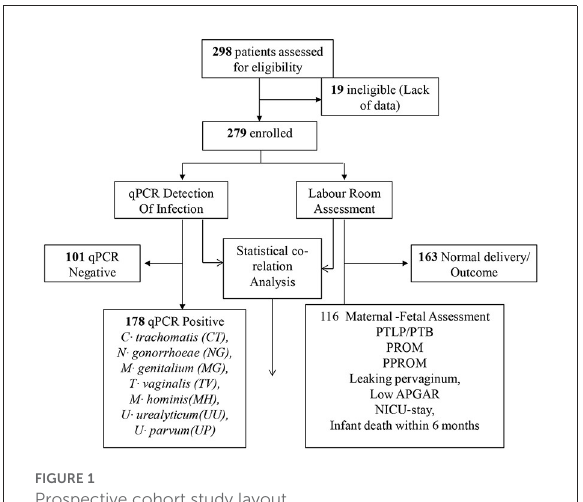
FIGURE1 Prospective cohort study